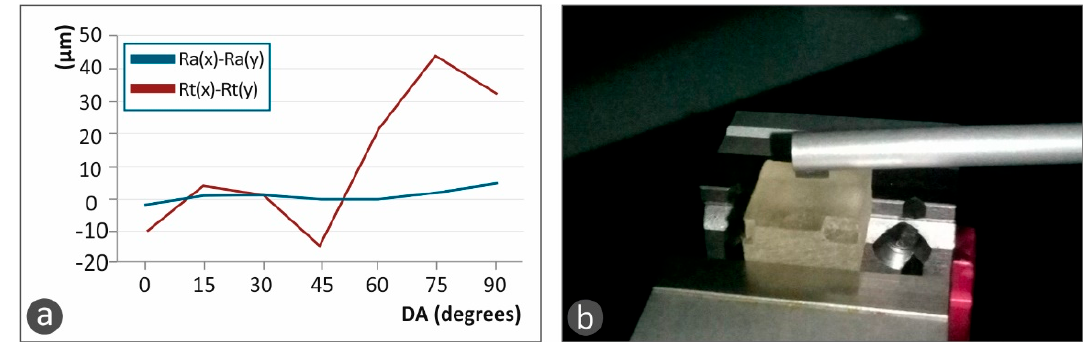
(cid:16) (cid:17) Figure 11. ( a ) Trend lines for ( Ra x − Ra y ) (cid:3435)(cid:1844)(cid:1853) (cid:3051) − (cid:1844)(cid:1853) (cid:3052) (cid:3439) and ( Rt x − Rt y ); ( b ) Mitutoyo Surftest RJ-210 tester, Ra x − Ra y Figure 11. ( a ) Trend lines for ( Ra x − Ra y ) and ( Rt x − Rt y ); ( b ) Mitutoyo Surftest RJ-210 tester, Figure 11. ( a ) Trend lines for ( Ra x − Ra y ) (cid:3435)(cid:1844)(cid:1853) (cid:3051) − (cid:1844)(cid:1853) (cid:3052) (cid:3439) and ( Rt x − Rt y ); ( b ) Mitutoyo Surftest RJ-210 tester, measuring the surface roughness on a specimen of this work. measuring the surface roughness on a specimen of this work. measuring the surface roughness on a specimen of this work.